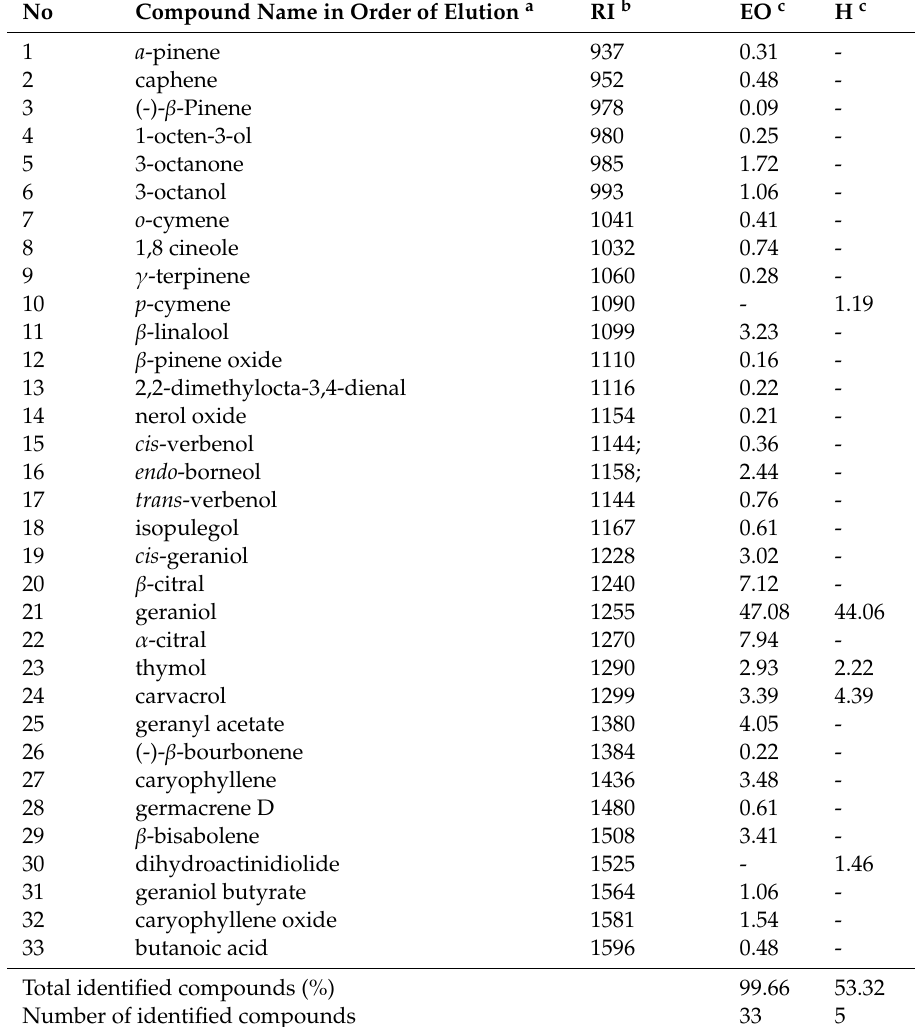
Table 1. Chemical composition of essential oil (EO) and hydrosol (H), along with percentage contents of